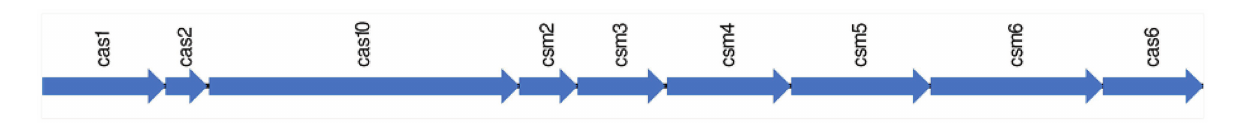
FIGURE 1 | The cluster of genes cas of the CRISPR-Cas subtype III-A of S. aureus system. The annotation genes cas was done in EasyFig